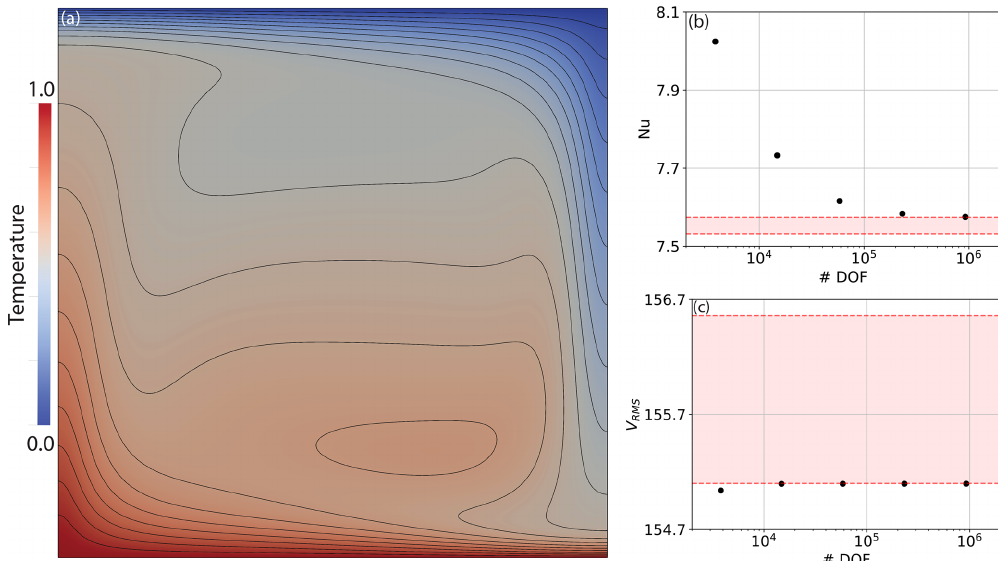
Figure 3. Results from Firedrake simulations configured to reproduce the 2-D compressible benchmark case from King et al. (2010) at Ra = 10 5 and Di = 0 . 5: (a) final steady-state (full) temperature field, with contours spanning temperatures of 0 to 1 at 0.05 intervals; (b) Nusselt number vs. number of pressure and velocity DOFs for a series of uniform, structured meshes; (c) rms velocity vs. number of pressure and velocity DOFs. The range of solutions provided by different codes in the King et al. (2010) benchmark study is bounded by dashed red lines.